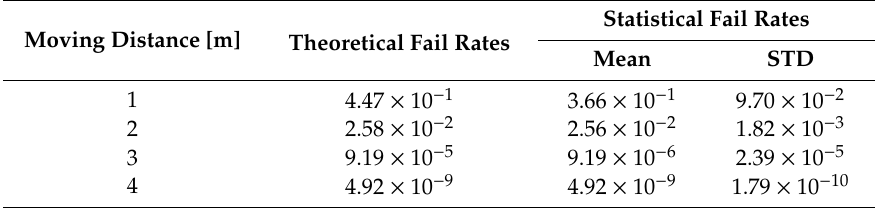
Table 5. Statistical parameter of fail rates as function of the geometry change.